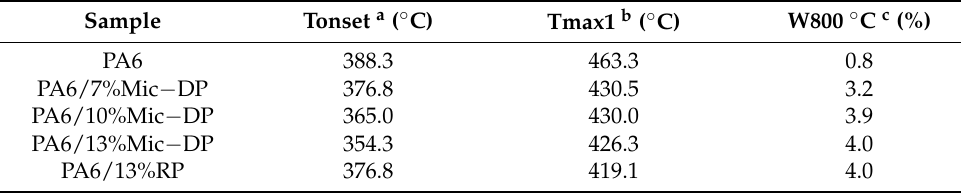
Figure 4. TG ( a ) and DTG ( b ) curve of PA6 samples. Table 5. Thermal decomposition characteristic dates of PA6 samples.